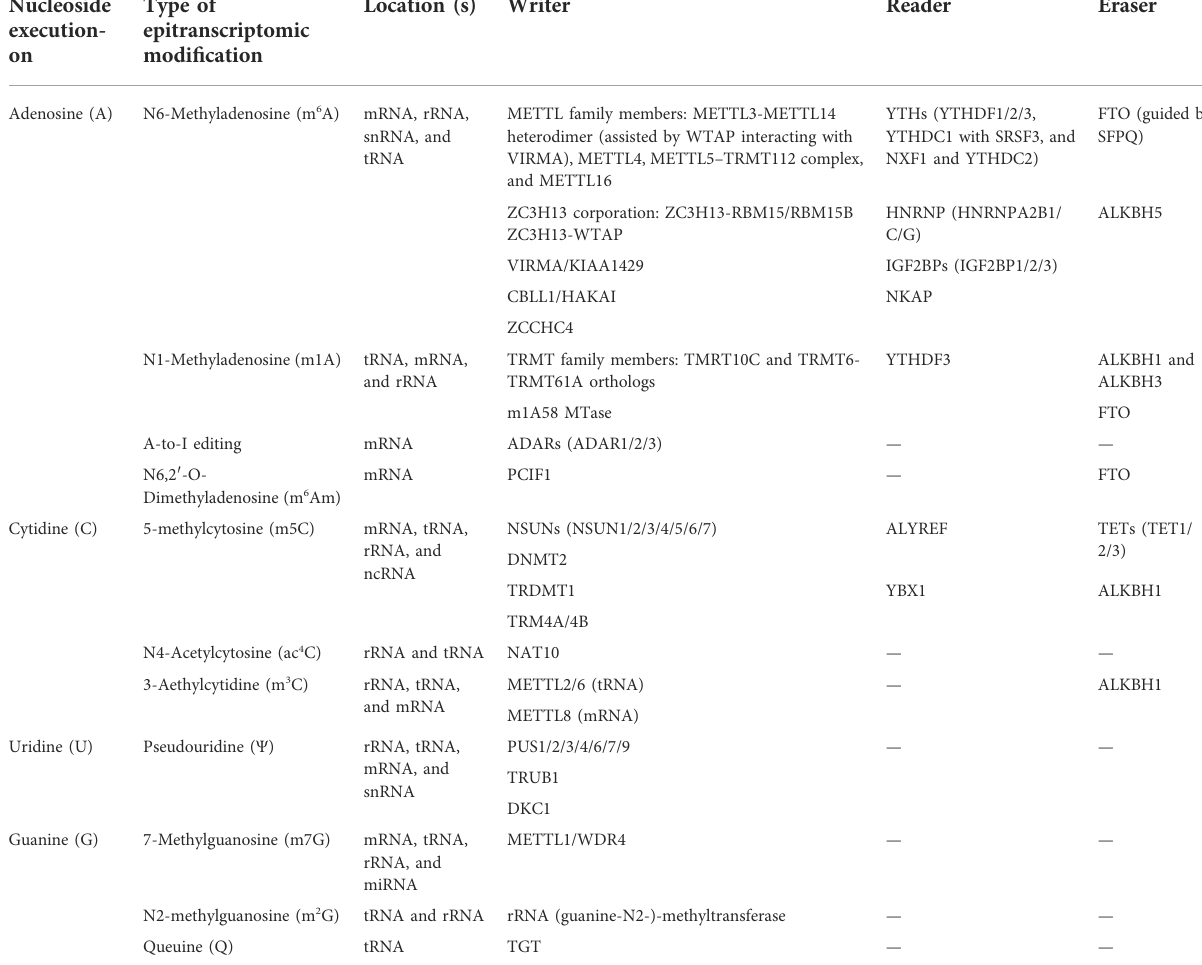
TABLE 1 Examples of RNA-modifying proteins and associated epitranscriptomic modi fi